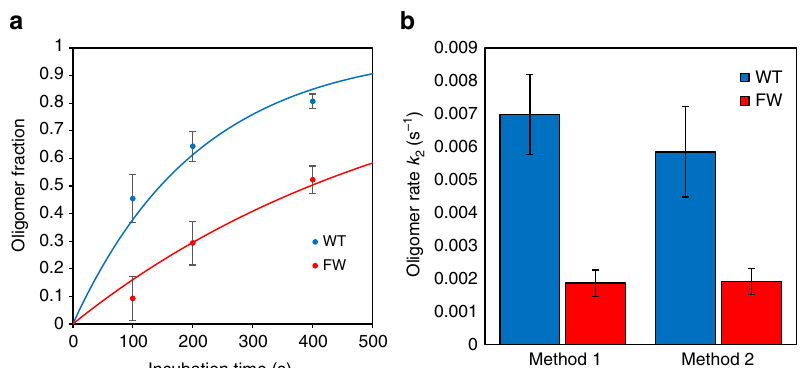
Fig. 5 Measured oligomerization rate based on A3G in a dissociable state over time. a Fraction of bound A3G in the stable oligomer state as a function of incubation time at 50 nM. Values are calculated by dividing the amount of A3G that unbinds in buffer by the original amount of A3G after incubation ( A dis and A total from the fi tting of dissociation curves). WT A3G transitions to the oligomer state more quickly than FW mutant. An exponential decay function is fi t to the data points to fi nd an oligomerization rate. b Comparison of calculated oligomerization rate k fi t (data 2 using the slow rate from the binding curve from Fig. 4) and this second method examining the amount of A3G that unbinds as a function of time. All error bars are SEM based on at least